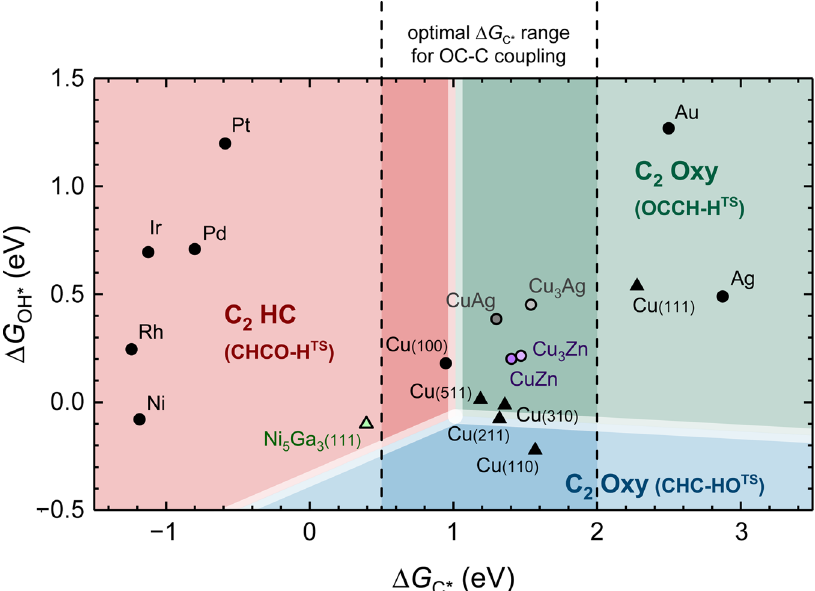
Fig. 5 Principles of tuning the C 2 Oxy/HC selectivity through the ( Δ G C* , Δ G OH* ) map. The ( Δ G C* , Δ G OH* ) selectivity map at U RHE = − 0.73 V at pH7. The CHCOH − , OCHCH − , and CH 2 CO-dominated regions are shown as red, blue, and green, respectively, with the rate-controlling TS structures shown in the parentheses. The vertical dashed lines identify the optimal Δ G C* range for OC-C coupling according to the prior work 35 . It should also be noted that the boundaries between the three regions shift with potential due to the different β value for the three protonation reactions. Note that the line width of